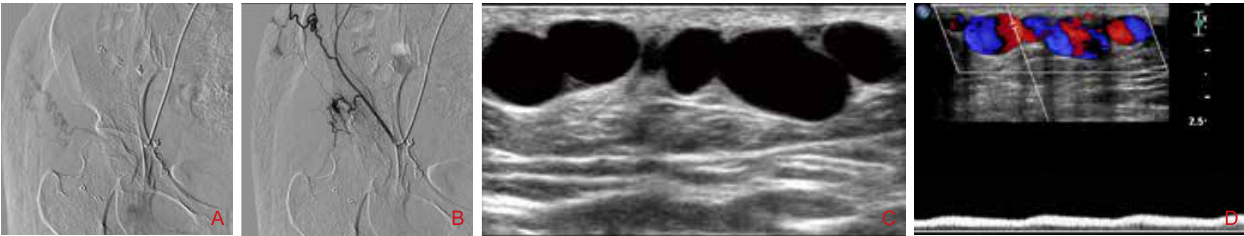
Figure 4 Coils were used to embolize the malformed blood vessels in the hip (A, B). After ethanol was injected into the tortuous dilated abnormal blood vessels, no change was seen in blood flow velocity on ultrasound (C,